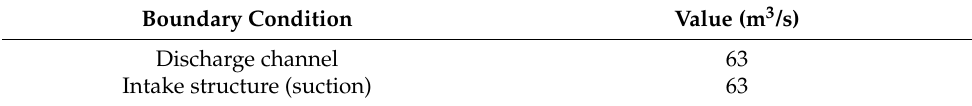
Table 2. LVNPP discharge and suction values used in the numerical